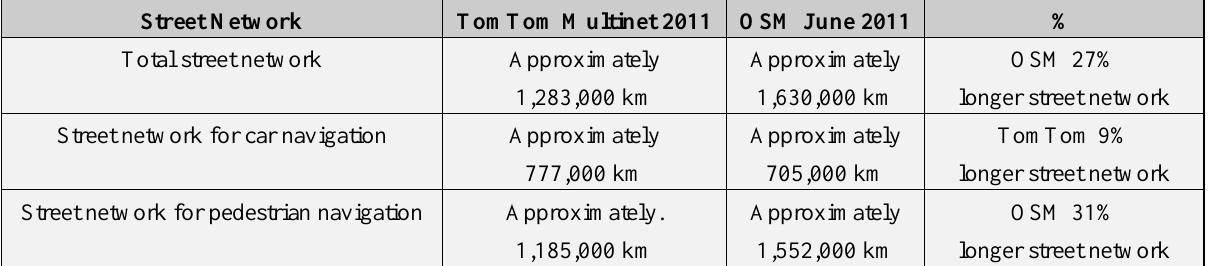
Table 1. Total Street Length of TomTom Multinet 2011 and OSM in June 2011.